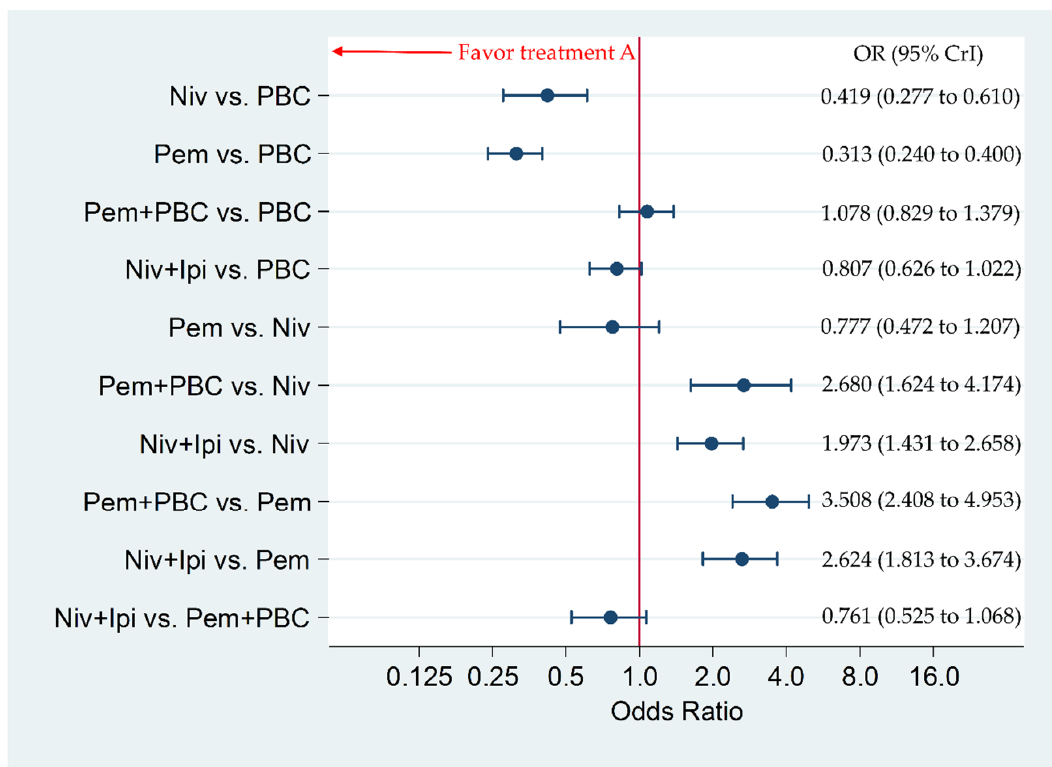
Figure 7. Comparative e ffi cacy among the five therapeutic regimens (Niv + Ipi, Pem + PBC, Pem, Niv, and PBC) in terms of incidence of any Grade 3–5 drug-related adverse events (G3–5AEs) in the overall patient group. Comparisons were expressed as Treatment A versus Treatment B. Data are expressed in terms of odds ratio (OR) and 95% credible intervals (CrIs); Niv, nivolumab; PBC, platinum-based chemotherapy; Pem, pembrolizumab; Ipi, ipilimumab.